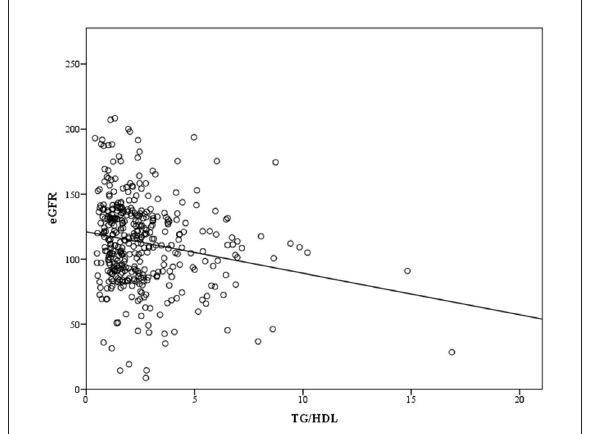
FIGURE1 Representation of the correlation analysis: there was a trend toward a negative correlation between triglyceride/high-density lipoprotein-cholesterol (TG/HDL-C) and estimated glomerular filtration rate (eGFR) levels.